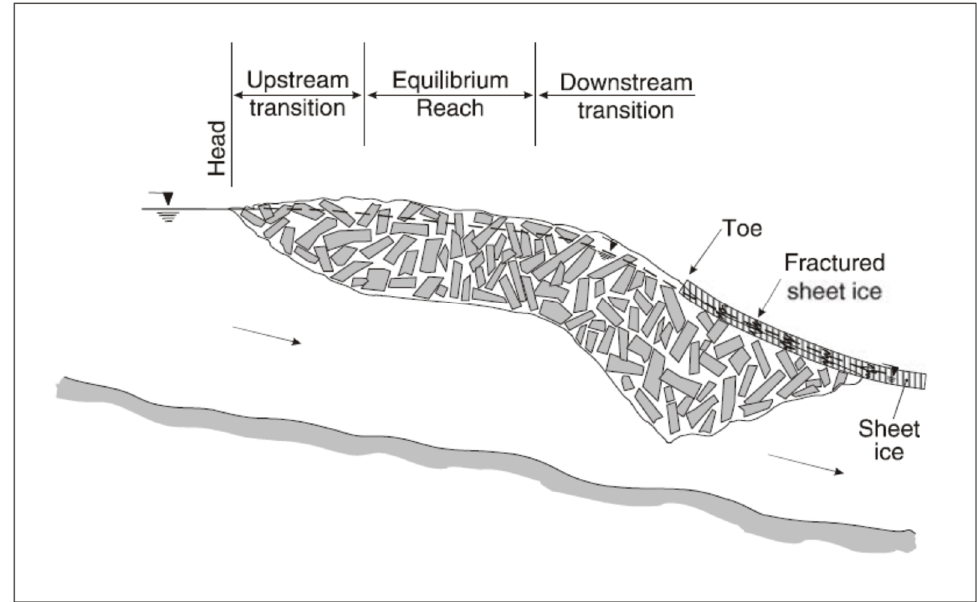
Figure 1. Schematic illustration of a fully developed ice jam. The equilibrium reach is usually much longer than indicated in the sketch but may be absent in short jams. Reproduced from [36]. Crown copyright, published by CGU-HS Committee on River Ice Processes and the Environment.